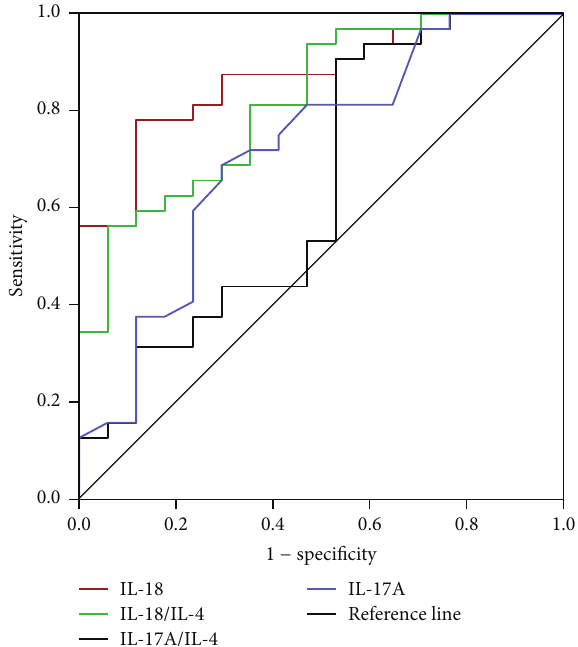
Figure 4: Receiver operating characteristics (ROC) curve of serum cytokines for differential diagnosis of LN-IV from LN-III and LN- V. The area under ROC curve of the serum cytokines levels IL-18, IL-17A, IL-18/IL-4, and IL-17A/IL-4 ratios was calculated and the accuracy of using these serum cytokines levels in the diagnosis of LN-IV from LN-III and LN-V was analyzed (data in Table